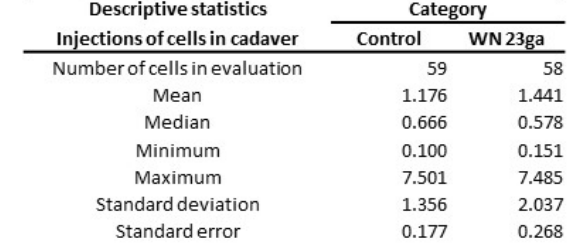
Figure 5. Analysis of Young’s modulus of cell injections by WN in tissue. Boxplots (medians, minimum, maximum) of the stiffness (kPa) measured by atomic force microscopy for controls and WN-injected pADSCs in fresh porcine cadaveric tissue are depicted. The control (untreated) cell monolayers revealed no significant differences in stiffness when compared to the WN group. Descriptive statistics of Young’s moduli in the control and WN-injected cells in fresh porcine cadaveric tissue. Medians with minimum and maximum, means, standard deviations and standard errors of the mean of both groups are depicted. ns p > 0.05. Abbreviations: WN—Williams needle.